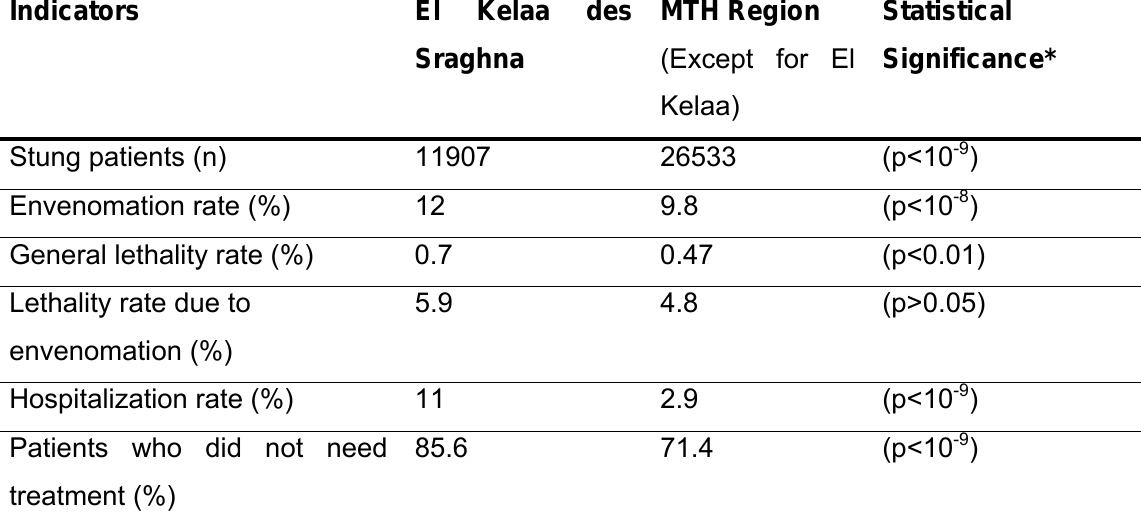
Table 3. Comparison of the evolutionary indicators of scorpion stings between